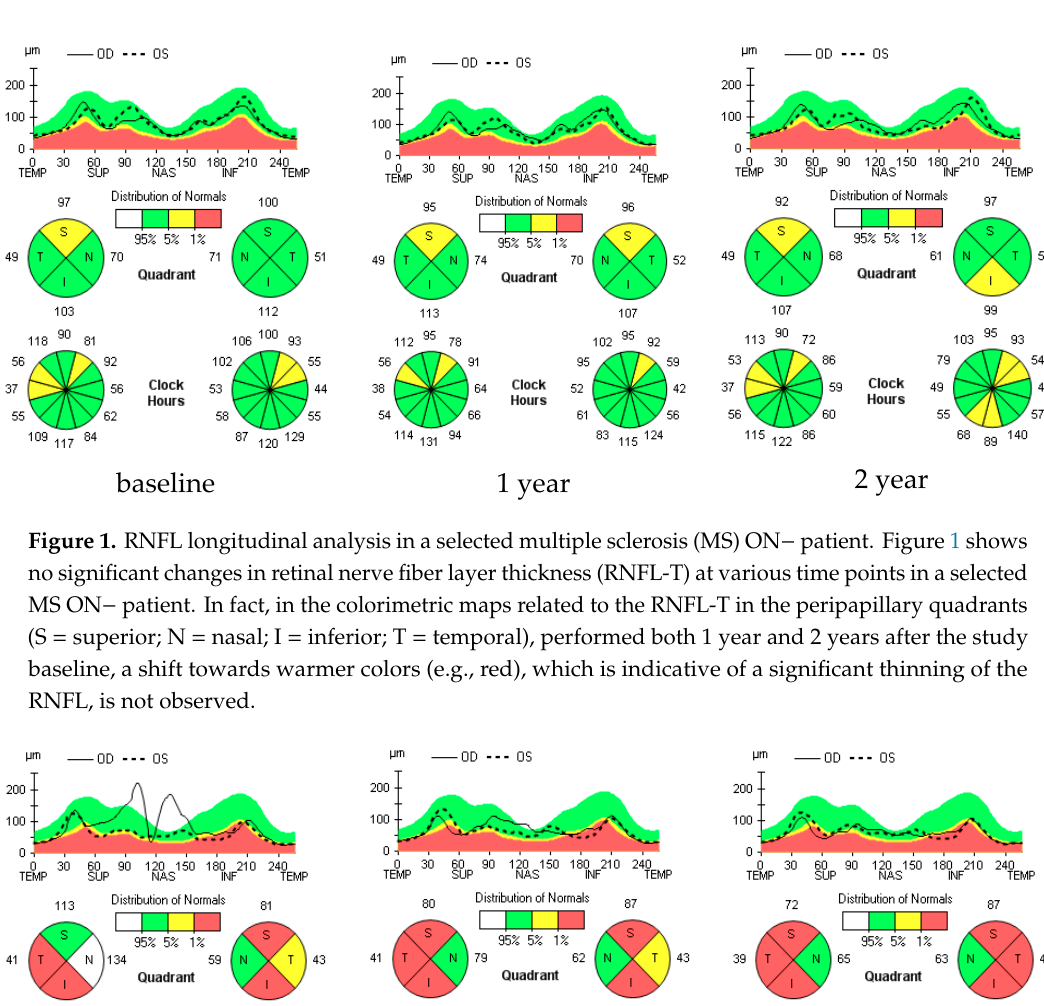
Values in bold indicate significant difference ( p values < 0.05). ON+ = patients with previous history of optic neuritis; ON − = patients without previous history of optic neuritis.